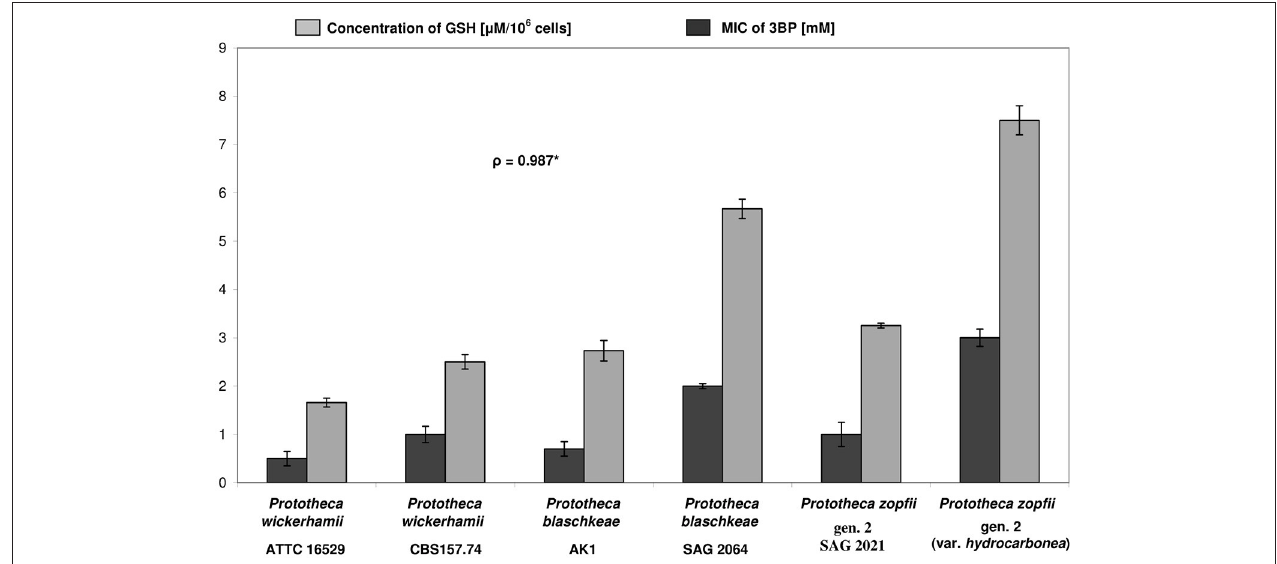
FIGURE 5 | Differences in susceptibility (MIC values) toward 3BP (evaluated by the microdilution assay) and in concentrations of intracellular glutathione (GSH) between different strains of Prototheca microalgae. *Pearson correlation coefficient; All tests were repeated at least three